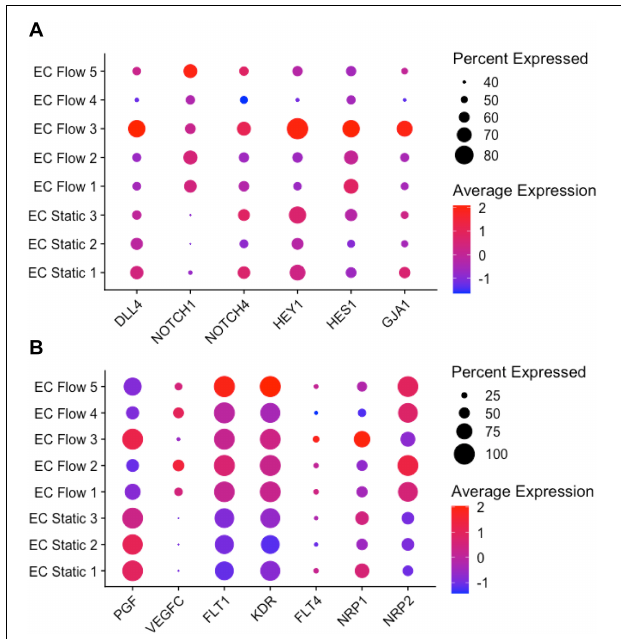
FIGURE 7 | NOTCH and VEGF pathway gene expressions in scRNASeq (HEL47.2). (A) , NOTCH pathway gene expression in flow and static clusters. (B) , VEGF pathway genes in flow and static